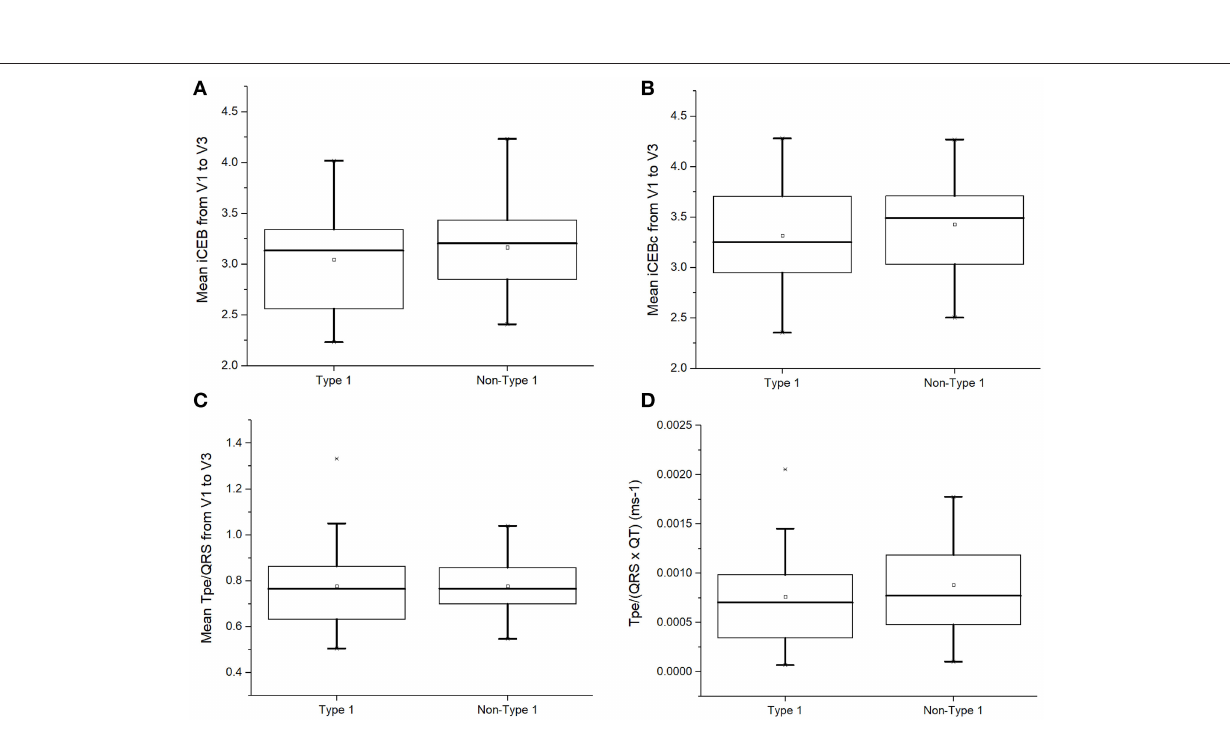
Frontiers in Cardiovascular Medicine |